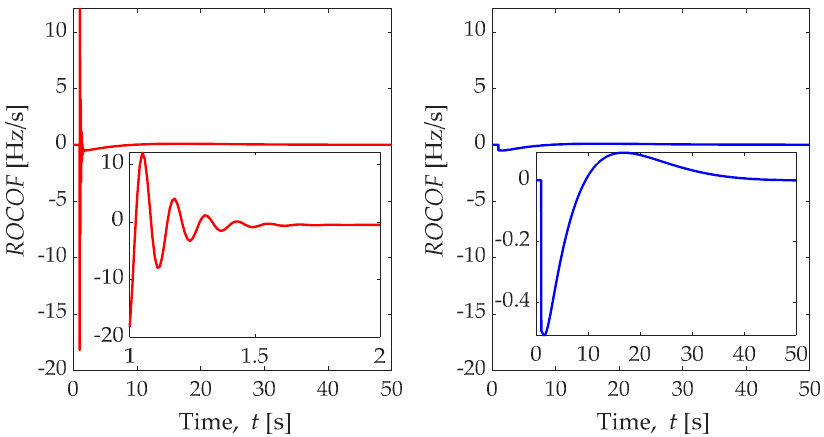
Figure 16. Rate of change of frequency ( ROCOF in Hz/s) calculated using a one-step incremental difference in a single area power system considering high sampling frequency measurement where the high-speed oscillation of the frequency response is capture (red colour) and relatively low sampling frequency (blue colour).